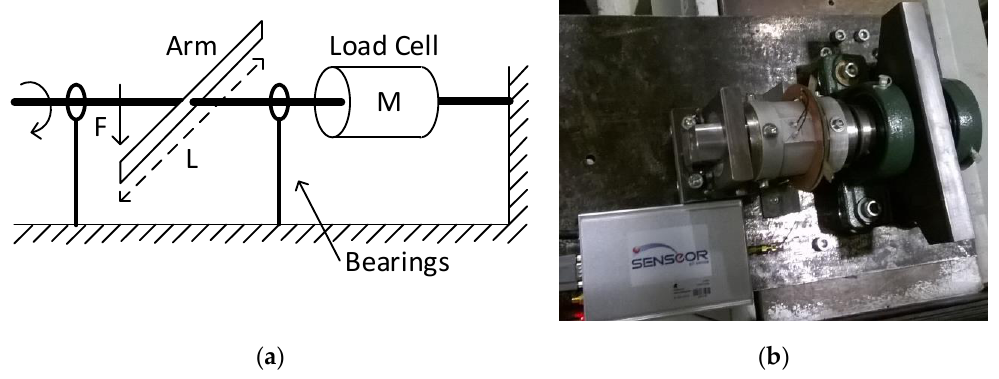
Figure 4. ( a ) Simplified schematic representation of the calibration setup; ( b ) detail of the load cell, strain sensors and moveable arm.